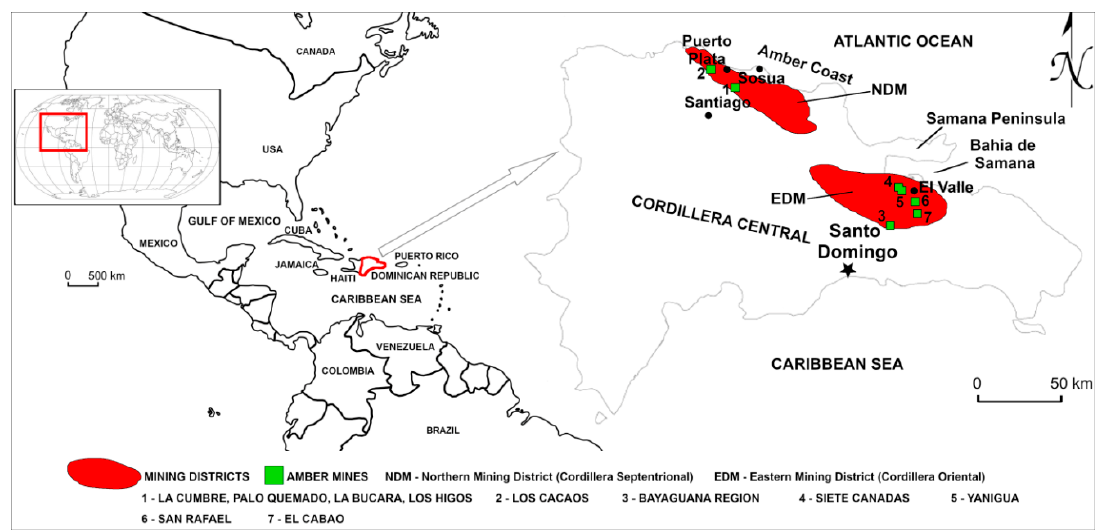
Figure 1. Sketch map of the Dominican Republic with the location of the amber deposits in Santiago Province and Hato Mayor Province.